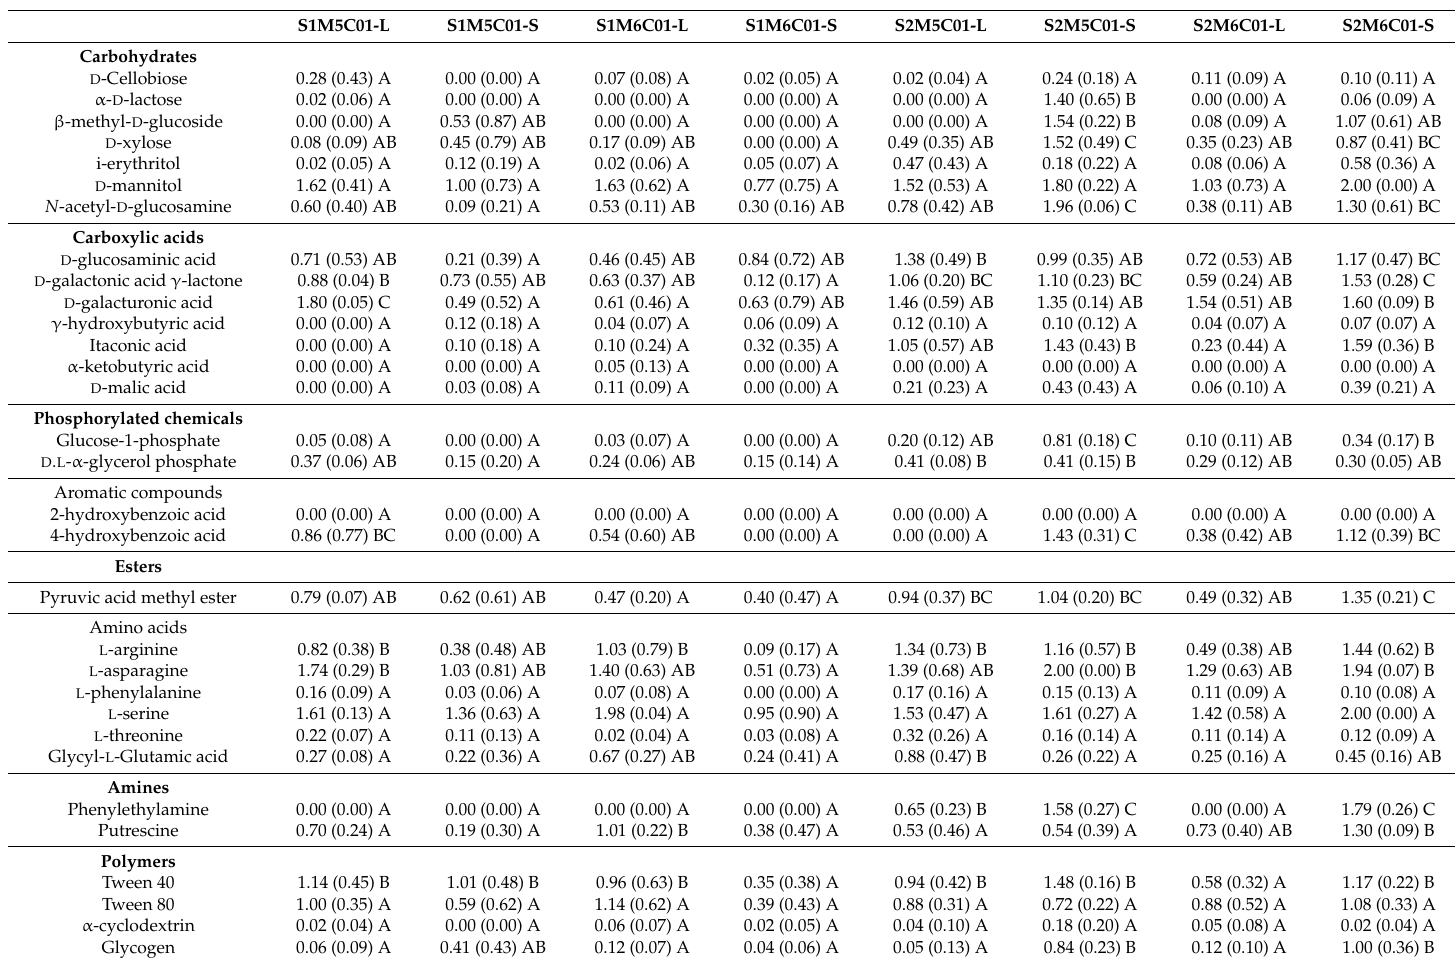
Table 1. Statistical comparison of carbon consumption by lichen (-L) and substrate (-S) microbiotas of M5C01 and M6C01 from both sampling sites (S1 and S2). Average absorbance and standard deviation are shown. In rows, the same capital letter indicates no significant difference according to Games–Howell post hoc test ( p <